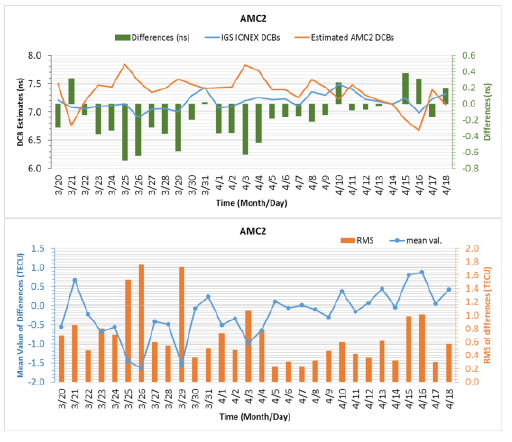
Figure 3. GPS-TEC time series data from selected IGS stations during the period from March 20 to April 18, 2010. In Figure 3, blue vertical line show the earthquake occurrence moment; black line show estimated GPS-TEC variations; blue line show upper bound (UB); red line show lower bound (LB); dashed black line show median values (MM); black coloured bars show positive anomalies; red coloured bars show negative anomalies before and after the